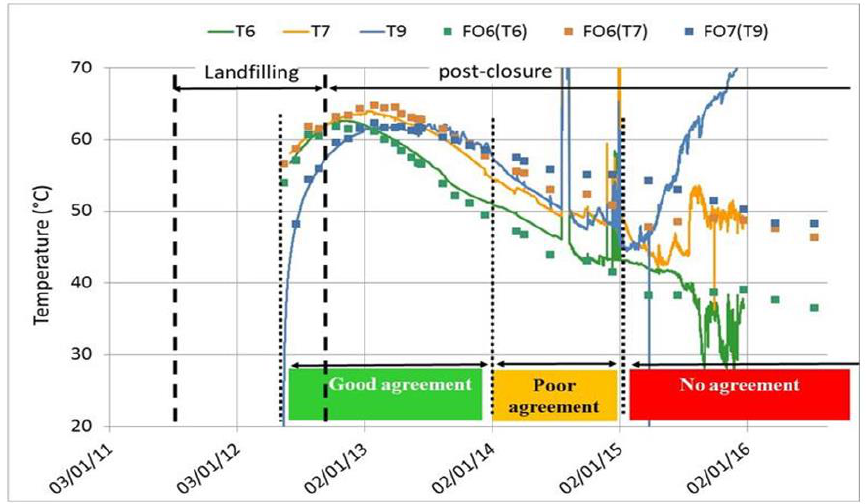
Figure 6. Evolution of point sensor T6, T7 and T9 and data recorded from optical fibres FO6 and FO7 at the same position.